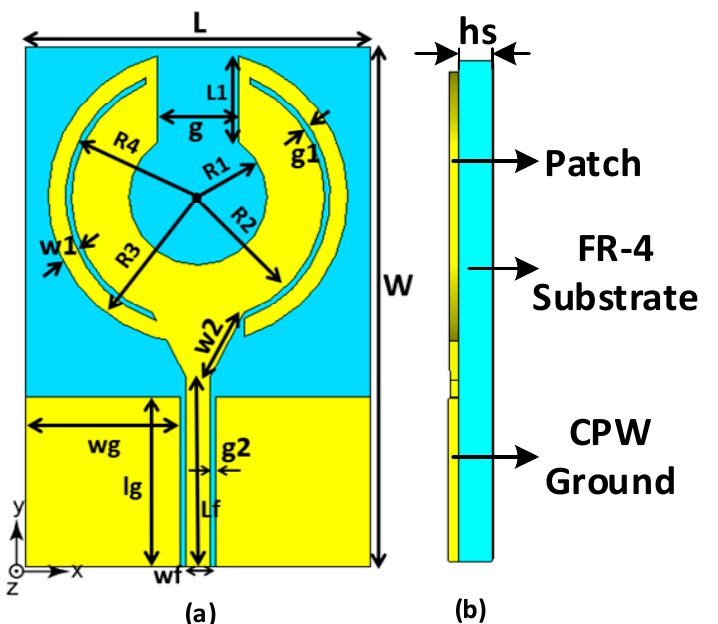
Figure 1. ( a ) Shows the diagram of unit cell of the MIMO antenna, and ( b ) shows the antenna’s side